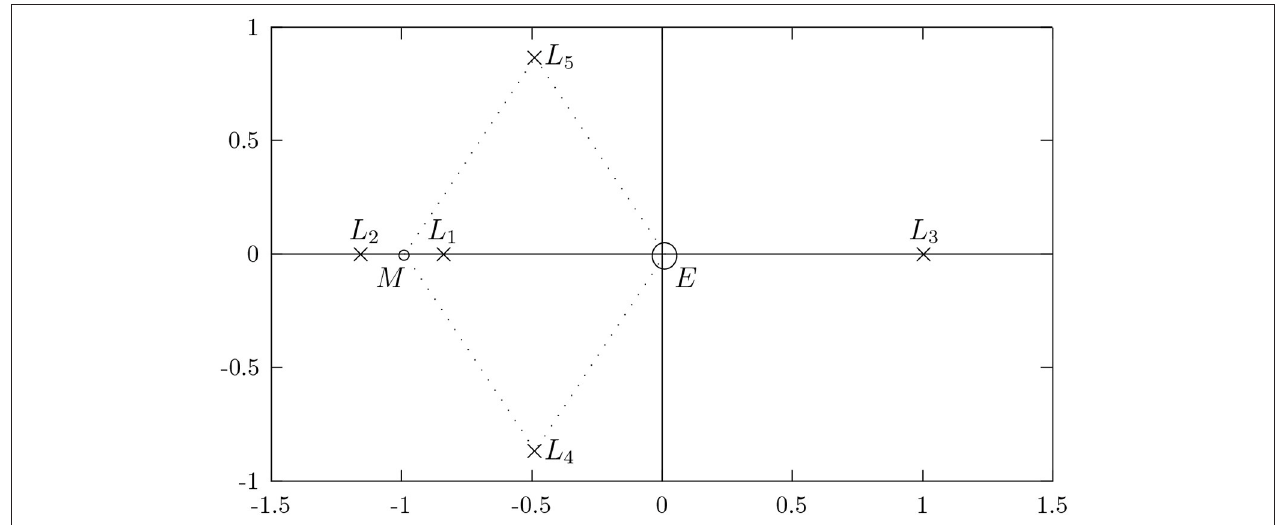
FIGURE 1 | The restricted three body